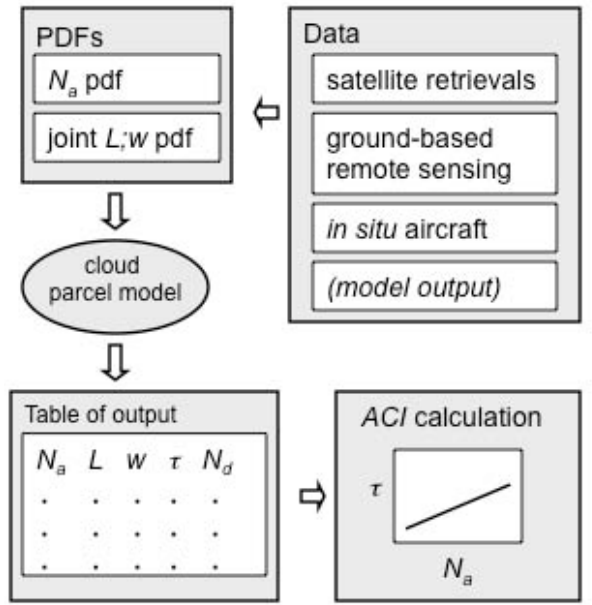
Fig. 5. Flow chart of the random sampling method for an observationally-based approach to ACI calculations. PDFs for input to a process-scale model can be built from a variety of sources in- cluding model output and measurements made at a range of